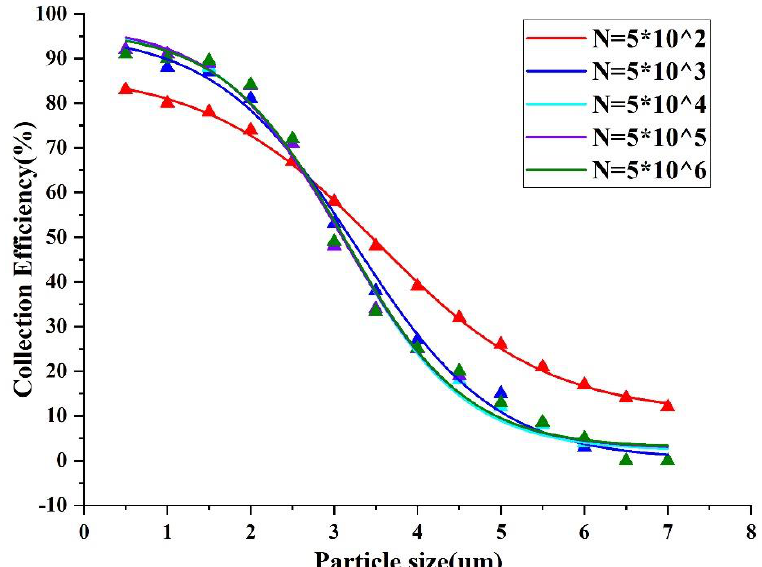
Figure 2. Grid irrelevance verification.